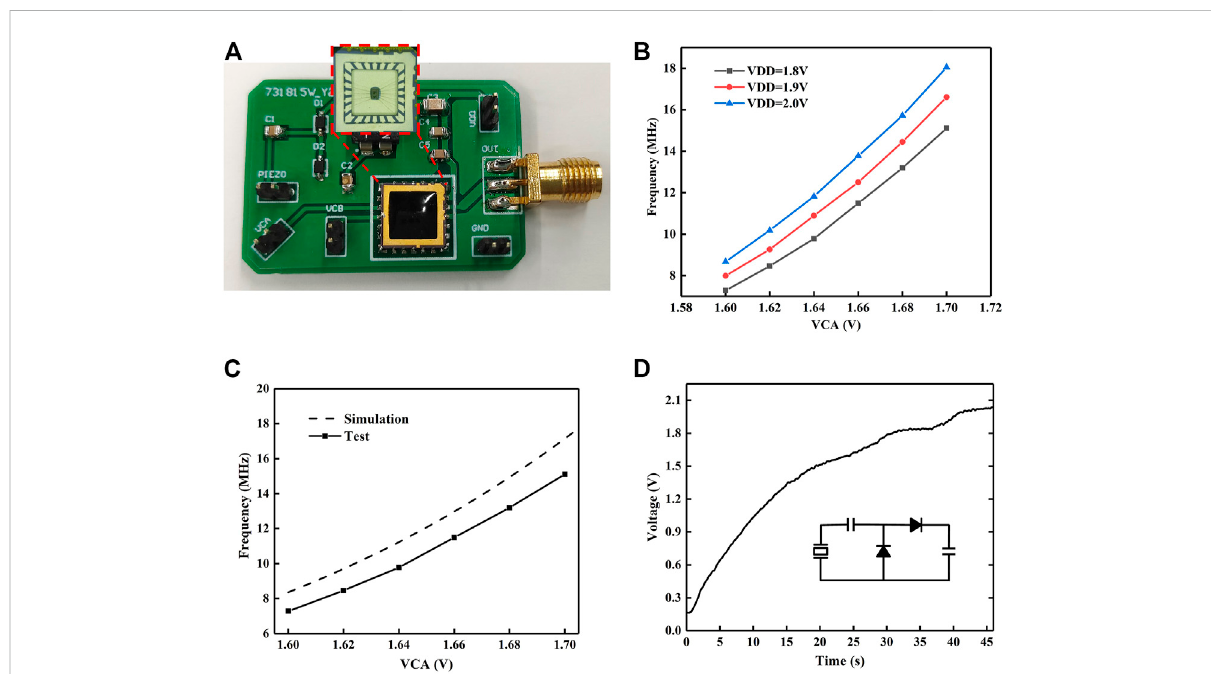
FIGURE 5 Low-power wireless transmit unit tests. (A) PCB test board for the chip; (B) test for the variation curve of oscillation frequency with VDD; (C) comparison of simulation and test results of output frequency variation with VCA; and (D) charging of the capacitor as the device is pressed and released by the human hand.